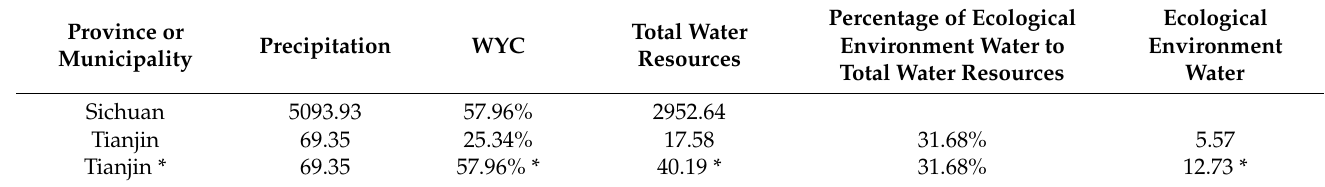
Table 1. Comparison of water resources of Tianjin municipality and Sichuan Province in 2018 (billion m 3